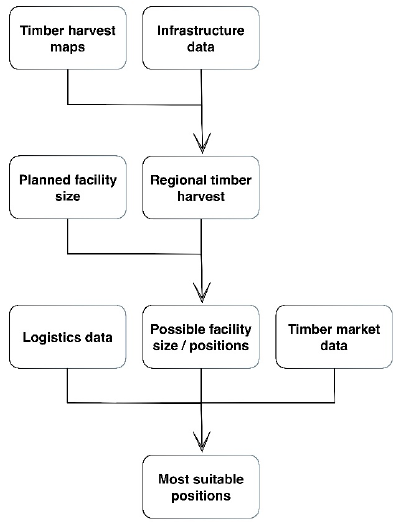
Figure 1. Simplified workflow of the approach showing necessary data and intermediate results for finding the most suitable facility positions.